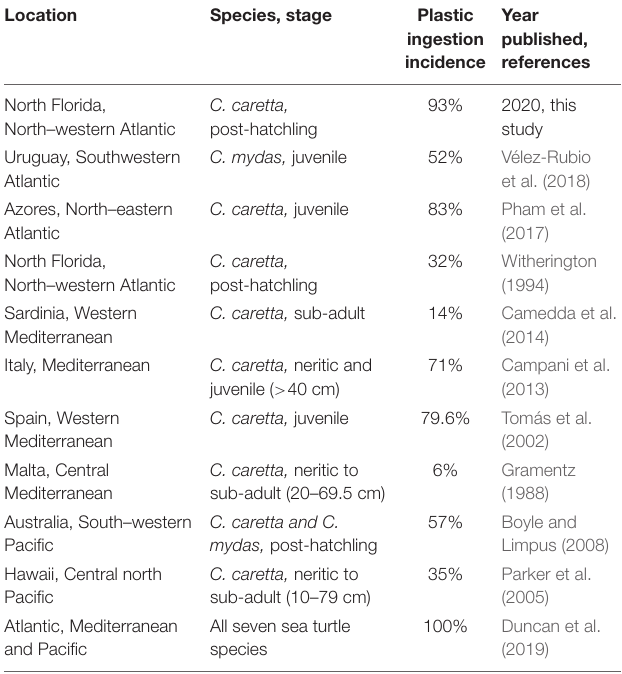
TABLE 1 | Comparison of sea turtle plastic ingestion incidence across research